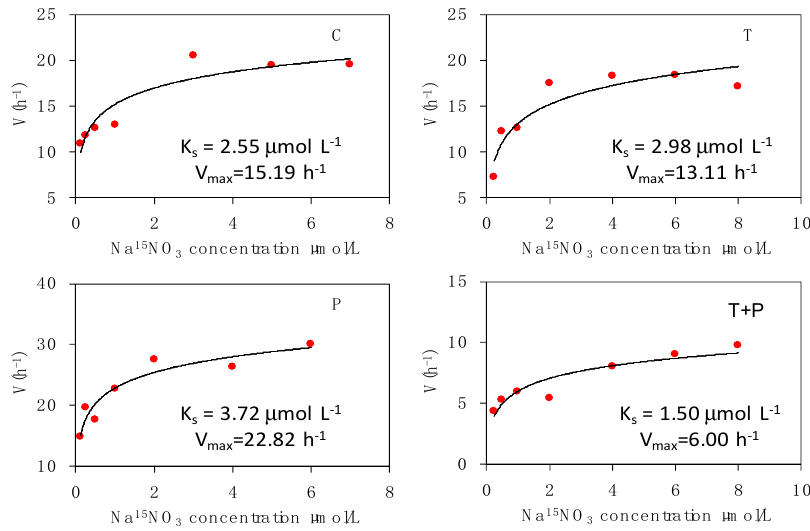
Figure 4. Nitrate uptake kinetic curves for phytoplankton in the four treatments. For abbreviations used, see Figure 1.